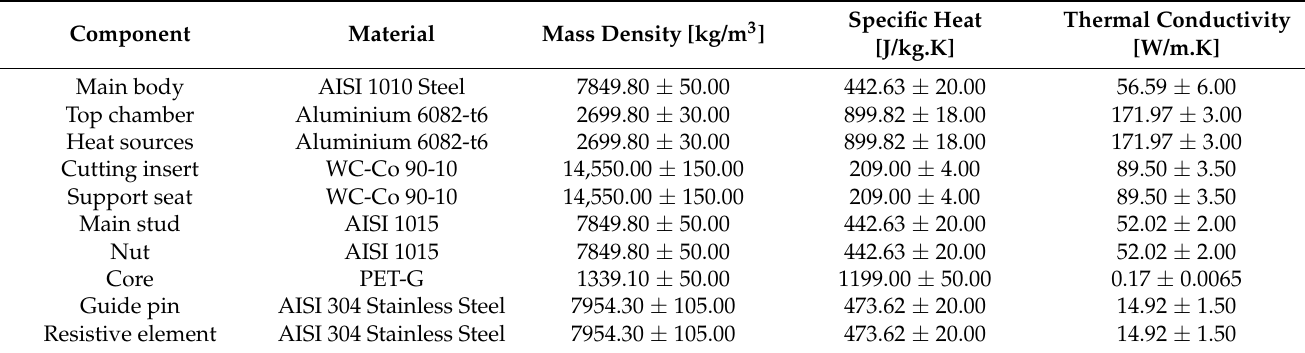
Table 1. Materials mass density and thermal